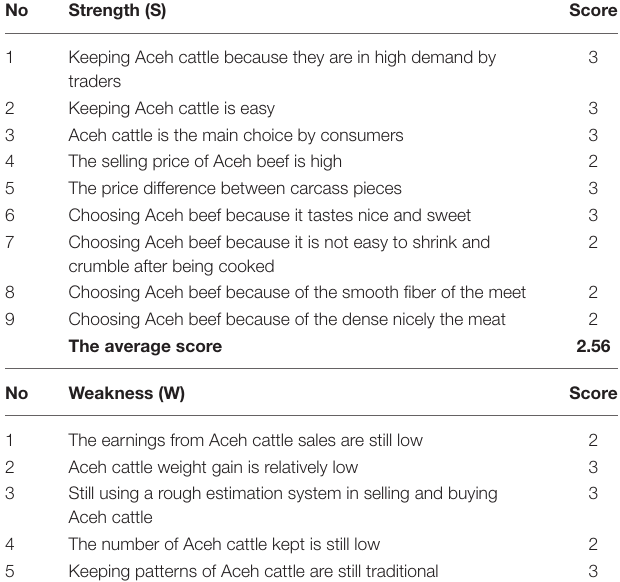
TABLE 2 | The results of the quantification SWOT (strengths, weaknesses, opportunities, and threats) analysis of the economic potential of Aceh cattle are based on farmers, traders, and consumers’